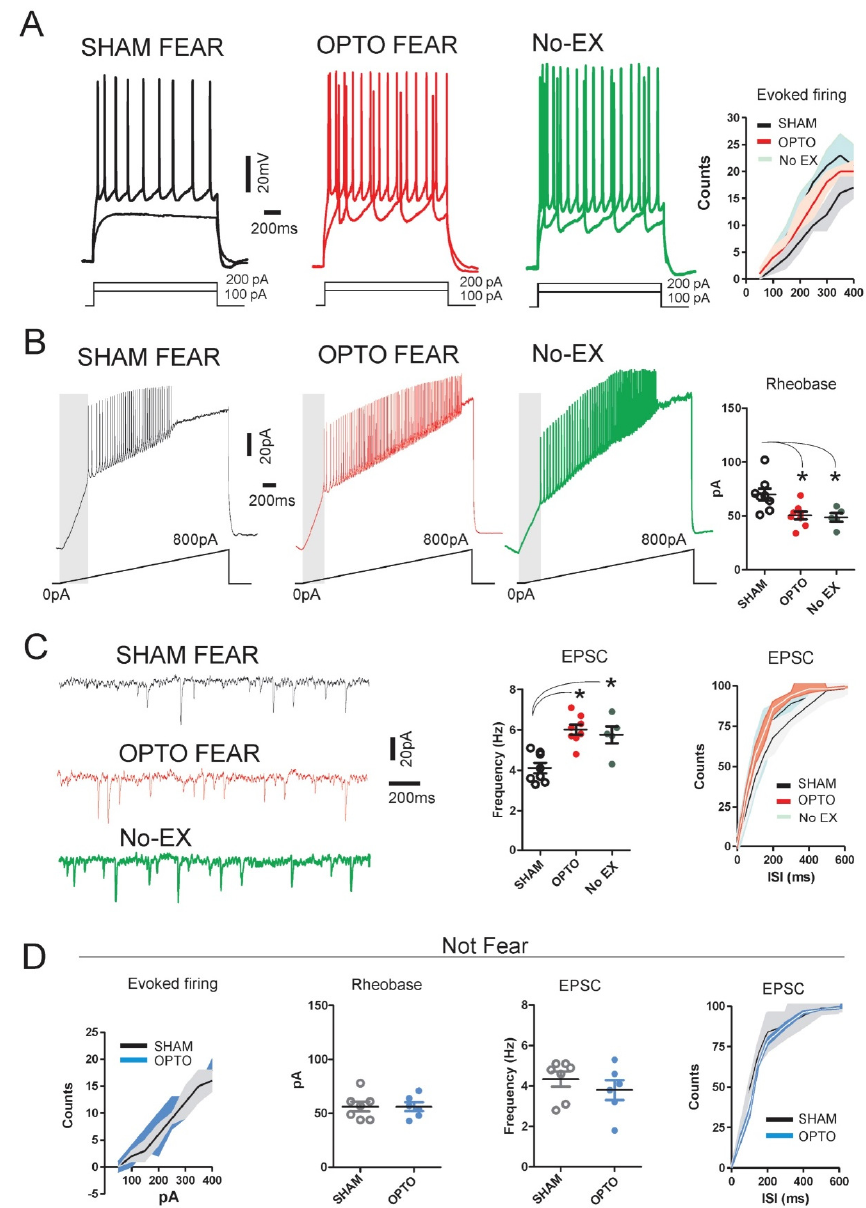
Figure 2. Modulation of cellular excitability of Prelimbic (PrL) pyramidal neurons by optogenetic stimulation. ( A ) Repre- sentative traces in current-clamp configuration reporting evoked firing activity triggered by a series of depolarizing current steps (0 to 400 pA) applied to PrL pyramidal neurons of SHAM FEAR (black, n = 8 neurons from 5 mice), OPTO FEAR (red, n = 8 neurons from 5 mice), and No-EX (green, n = 5 neurons from 3 mice) groups. The cumulative plot shows the changes in firing activity. ( B ) Representative traces of PrL pyramidal neurons of SHAM FEAR (black, n = 8 neurons from 5 mice), OPTO FEAR (red, n = 8 neurons from 5 mice), and No-EX (green, n = 5 neurons from 3 mice) groups showing the firing activity triggered by linear depolarization from 0 to 800 pA. Graph (on the right) reports the effects of optogenetic stimulation on rheobase value. Namely, PrL pyramidal neurons of OPTO FEAR and No-EX groups recorded after optogenetic stimulation showed a clear reduction in the rheobase value in comparison to neurons of SHAM FEAR group (* at least p = 0.01). ( C ) Representative traces of Excitatory Post-Synaptic Currents (EPSC) of PrL pyramidal neurons of SHAM FEAR (black, n = 8 neurons from 5 mice), OPTO FEAR (red, n = 8 neurons from 5 mice), and No-EX (green, n = 5 neurons from 3 mice) groups. Graph plot (in the middle) and cumulative curve (on the right) depict the clear increase in firing frequency in PrL pyramidal neurons of OPTO FEAR and No-EX groups (* at least p = 0.01). ( D ) Graphs and cumulative curves report no significant differences in cellular excitability in PrL pyramidal neurons of SHAM NOT FEAR (black) and OPTO NOT FEAR (blue) groups. Data are reported as median with interquartile